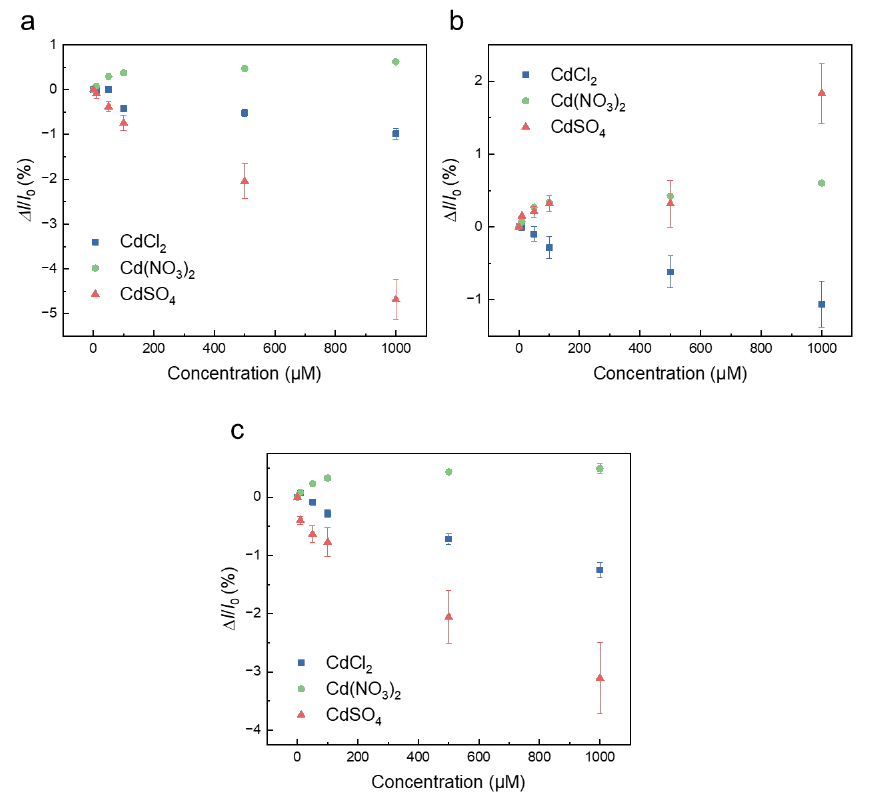
Sensors 2023 , 23 , x FOR PEER REVIEW